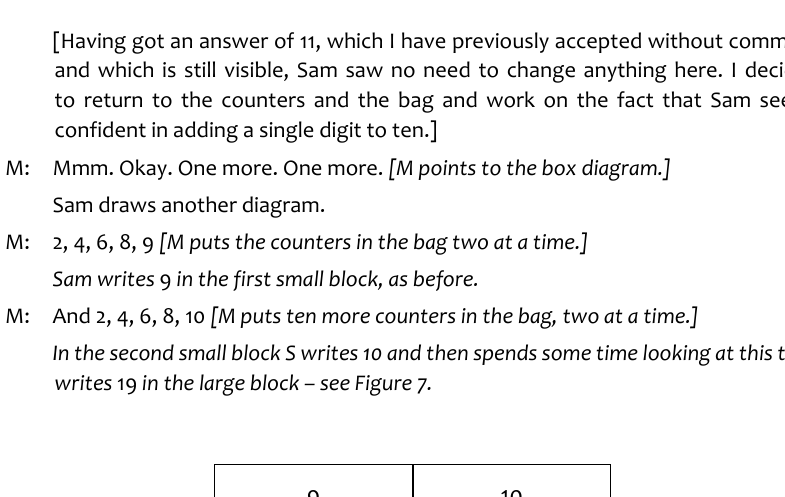
Figure 6: Sam’s solution to 9 and 11 part-part situation.